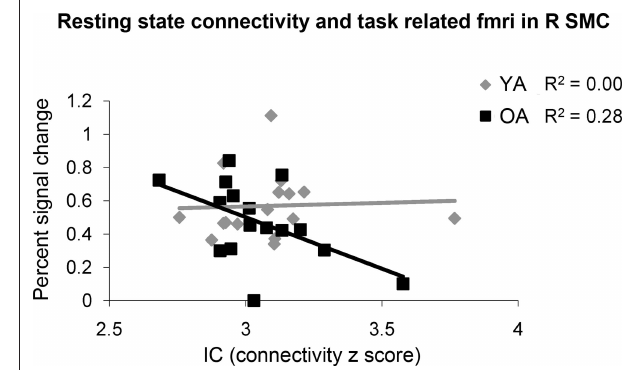
FIguRe 7 | The older adults (OA) had a negative correlation between resting functional connectivity strength in the right sensorimotor cortex (R SMC) ROI and fMRI activation in the same region, while the young adults (YA) did